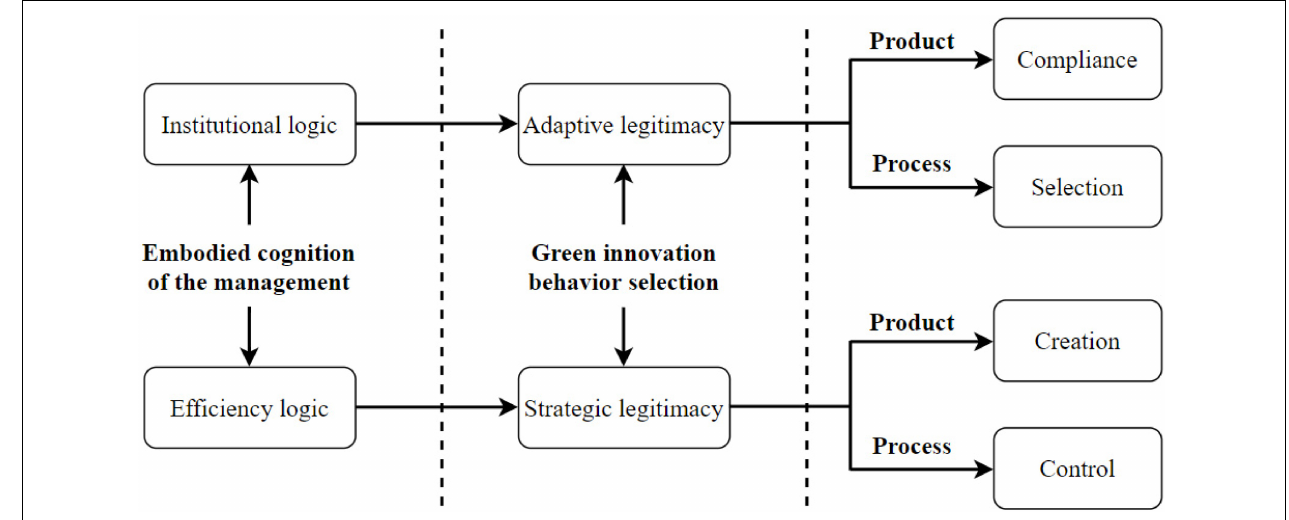
FIGURE 1 | Manufacturer decision of green innovation driven by cognition-behavior